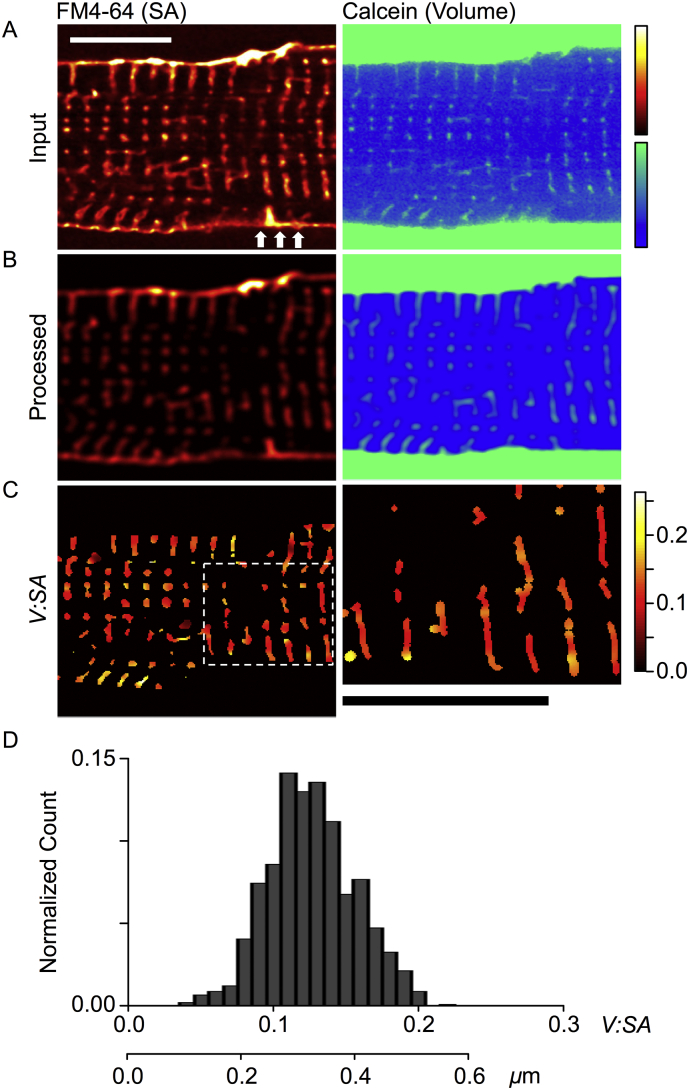
Application of the V:SA method to TTs in rabbit ventricular myocytes. (A) Shows a region of a myocyte dual labeled with FM4-64 for the surface membrane (left panel), and calcein for the extracellular space -which includes the TT lumen (right panel). (B) Shows the same optical sections after processing (background subtraction, PSF modification to a sphere and normalization). (C) The left panel shows the V:SA values calculated for pixels within the TT mask. The right panel shows a magnified view of the region marked in C (dashed white box), where the TT skeleton was dilated to reflect the calculated TT width and the color table indicates V:SA. Scale bars show 10 μm. (D) A histogram of V:SA values within the TT skeleton from the cell shown in A-C. The lower scale bar shows conversion from V:SA to TT diameter. Means of all data are given in Table 1.